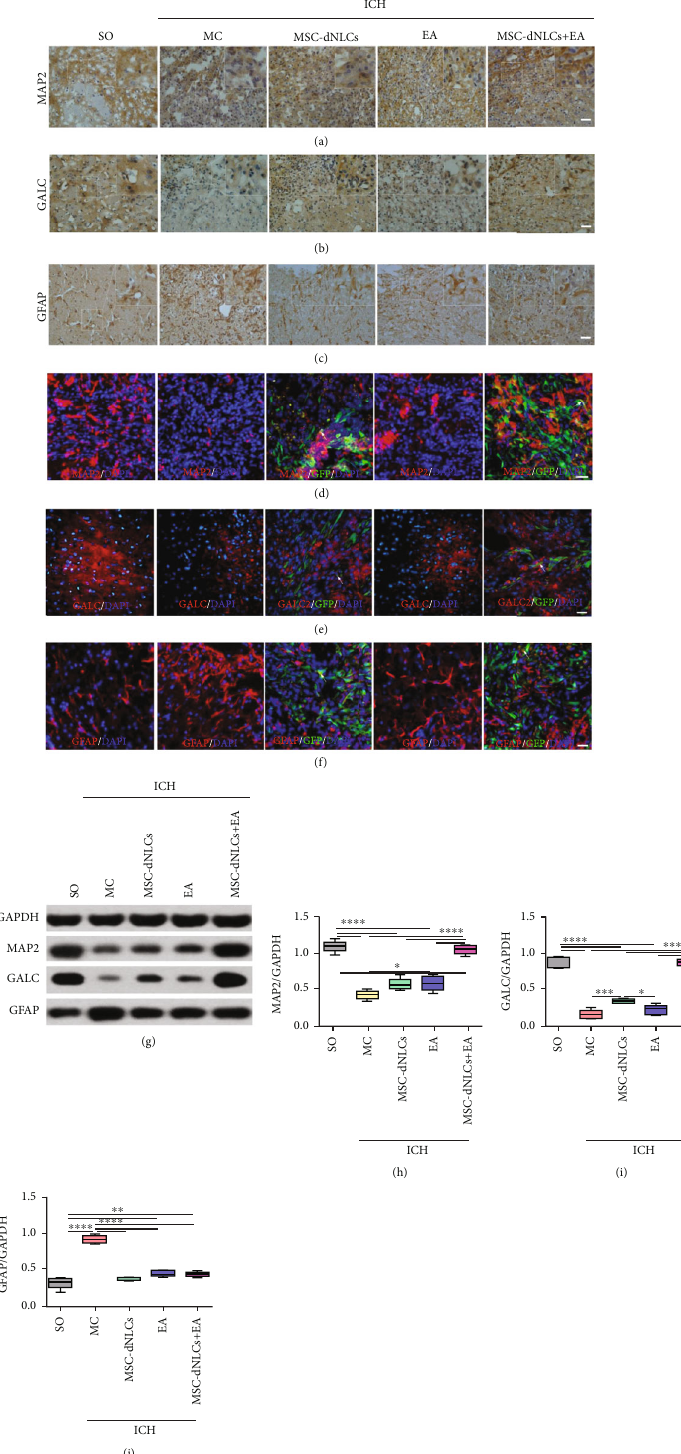
Figure 4: The expression of the MAP2, GALC, and GFAP proteins in di ff erent groups was detected using immunohistochemical staining and western blotting. (a – c) Representative images of MAP2 (a), GALC (b), and GFAP (c) immunohistochemical staining in the ipsilateral striatum of animals from di ff erent groups. Scale bar = 100 μ m . (d – f) Representative images of MAP2 (d), GALC (e), and GFAP (f) immuno fl uorescence staining in the ipsilateral striatum of rats from di ff erent groups. Scale bar = 100 μ m . (g – j) Representative results (g) and quantitative analyses (h – j) of western blotting showed the relative expression of the MAP2, GALC, and GFAP proteins in the ipsilateral striatum of rats from di ff erent groups ( n = 5 animals per group; ∗ P < 0 : 05 , ∗∗ P < 0 : 01 , ∗∗∗ P < 0 : 001 , and ∗∗∗∗ P < 0 : 0001